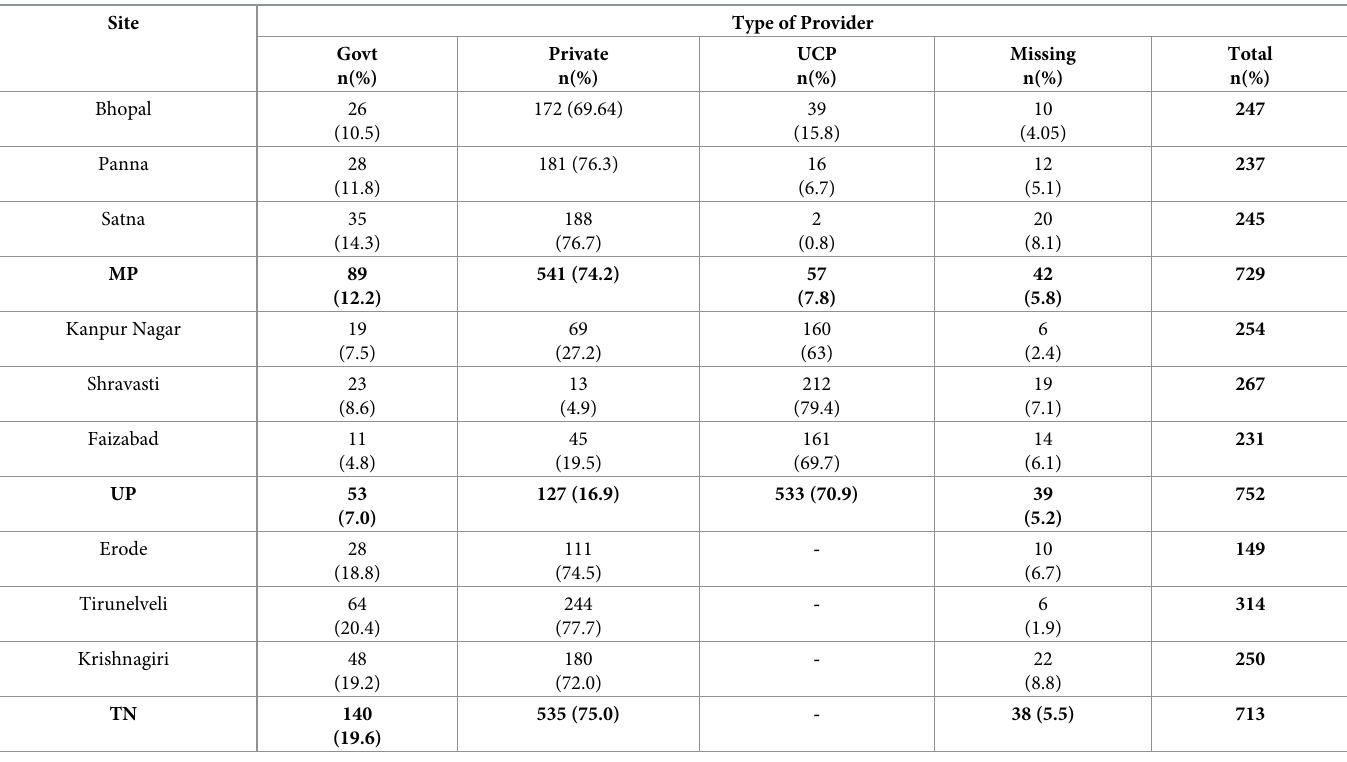
Table 6. Type of care provider sought.